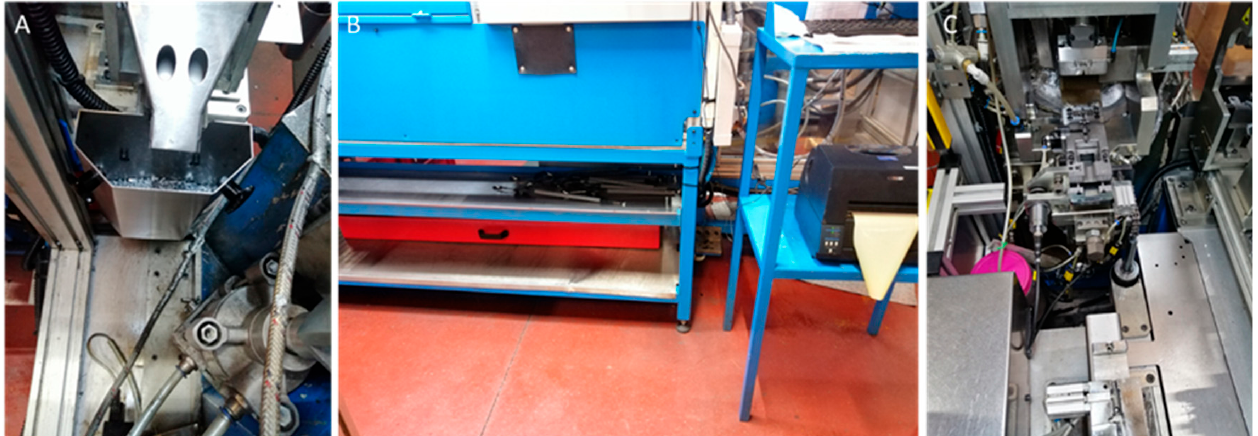
Figure 25. Equipment after the intervention: correct sprue storage in the dedicated container ( A ), lack of scattered sprues ( B ), and clean path up to the container after continuous production ( C ).